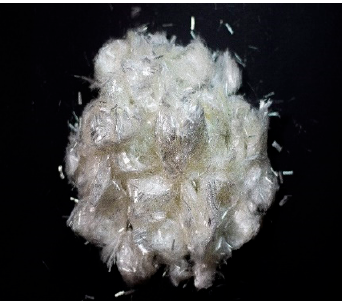
Figure 1. PVA fiber. Table 3. Specifications of PVA fiber.